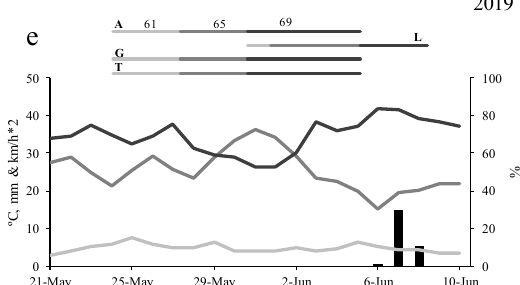
Figure 2. Meteorological parameters, rainfall (black bars), relative humidity, maximum temperature, wind speed (lines) and phenophases of flowering (stage 6): 61 (Beginning of flowering: 10% of flower caps fallen), 65 (Full flowering: 50% of flower caps fallen) and 69 (End of flowering) for four cultivars (T) ‘Treixadura’, (G) ‘Godello’, (L) ‘Loureira’, and (A) ‘Albariño’. a, b, c, d, e, sub-graphs of the years of the The Vitis vinifera L. pollen concentration during the study years, recorded by means of the volumetric Hirst pollen trap and the passive Cour pollen trap, the maximum temperature, and rainfall variation, and the length of the flowering phenological stage are each shown in Figure 3. The presence of Vitis vinifera L. airborne pollen was mainly registered during the last few days of stage 5 (inflorescence emergence) (data not shown) and the whole of stage 6 (Figure 3). The main pollen season (MPS) was defined using data from the Hirst and Cour traps. By means of the Hirst volumetric sampler, the MPS started on 24, 15 and 26 May in 2015, 2017 and 2019, respectively, whereas it started on June 4 and 9 in 2016 and 2018, respectively. The MPS ended on May 29 in 2017 and on June 3, 6,